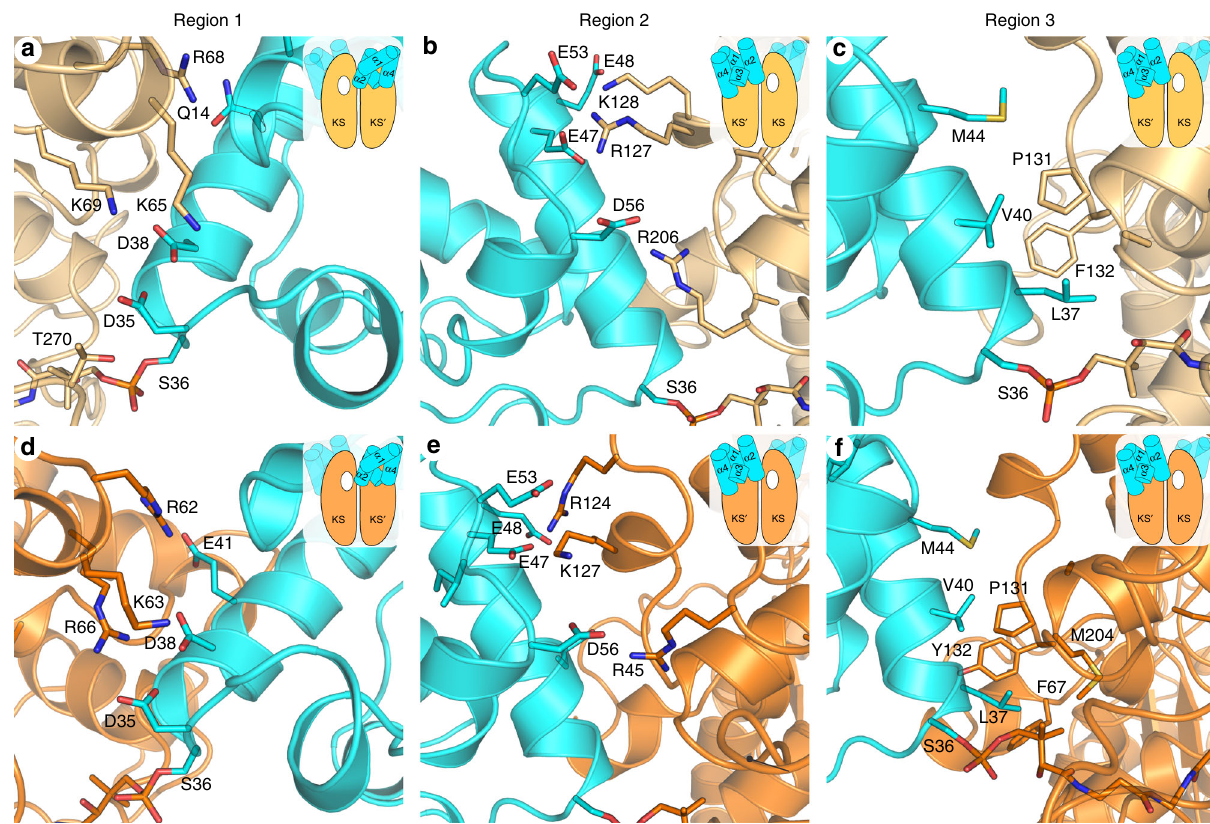
Fig. 3 AcpP – FabF and AcpP – FabB interface interactions. The FabF (light orange) and FabB (bright orange) interfaces can be broken up into three regions, the fi rst two are comprised of electrostatic interactions and the third is a hydrophobic patch. The above panels provide close-up views of these three regions and the cartoon inset provides context regarding the viewing angle and the positional relationship of AcpP (cyan) to the overall AcpP – KS complex. In addition, the white hole represents the active site to which the viewed AcpP is crosslinked as the majority of contacts are provided by the KS monomer not covalently crosslinked to AcpP. a A close-up view of the AcpP – FabF region 1 electrostatic interactions. b A close-up view of the AcpP – FabF region 2 electrostatic interactions. c A close-up view of the AcpP – FabF region 3 hydrophobic interactions. d A close-up view of the AcpP – FabB region 1